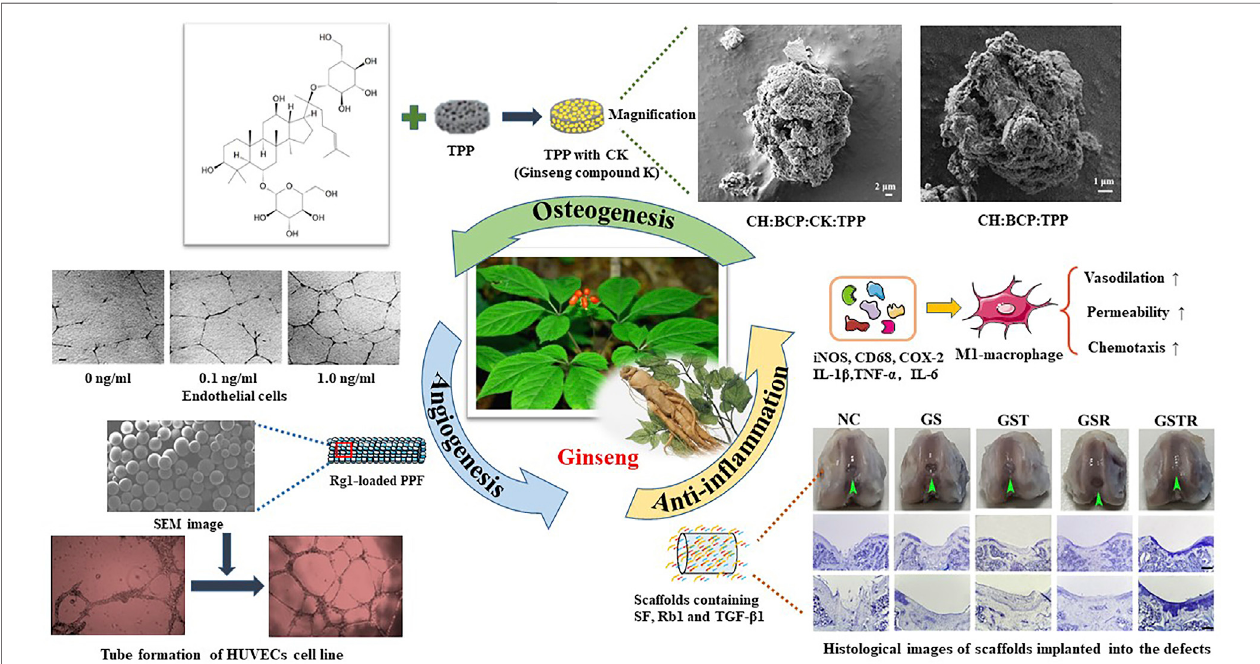
FIGURE2| Illustrationofginseng: theorigin, molecularstructure,and biomedical researches.Ginsenoside isthemajor active ingredient inginseng, including Rb1, Rb2, Rc, Rd, Re, Rg1, and so on. Thus far, ginseng has been frequently studied form the aspects of cells, biomaterials, and animals. It shows potent angiogenesis, osteogenesis, and anti-in fl ammation activity by inducing osteogenic cell proliferation, tube formation, and macrophage chemotaxis.